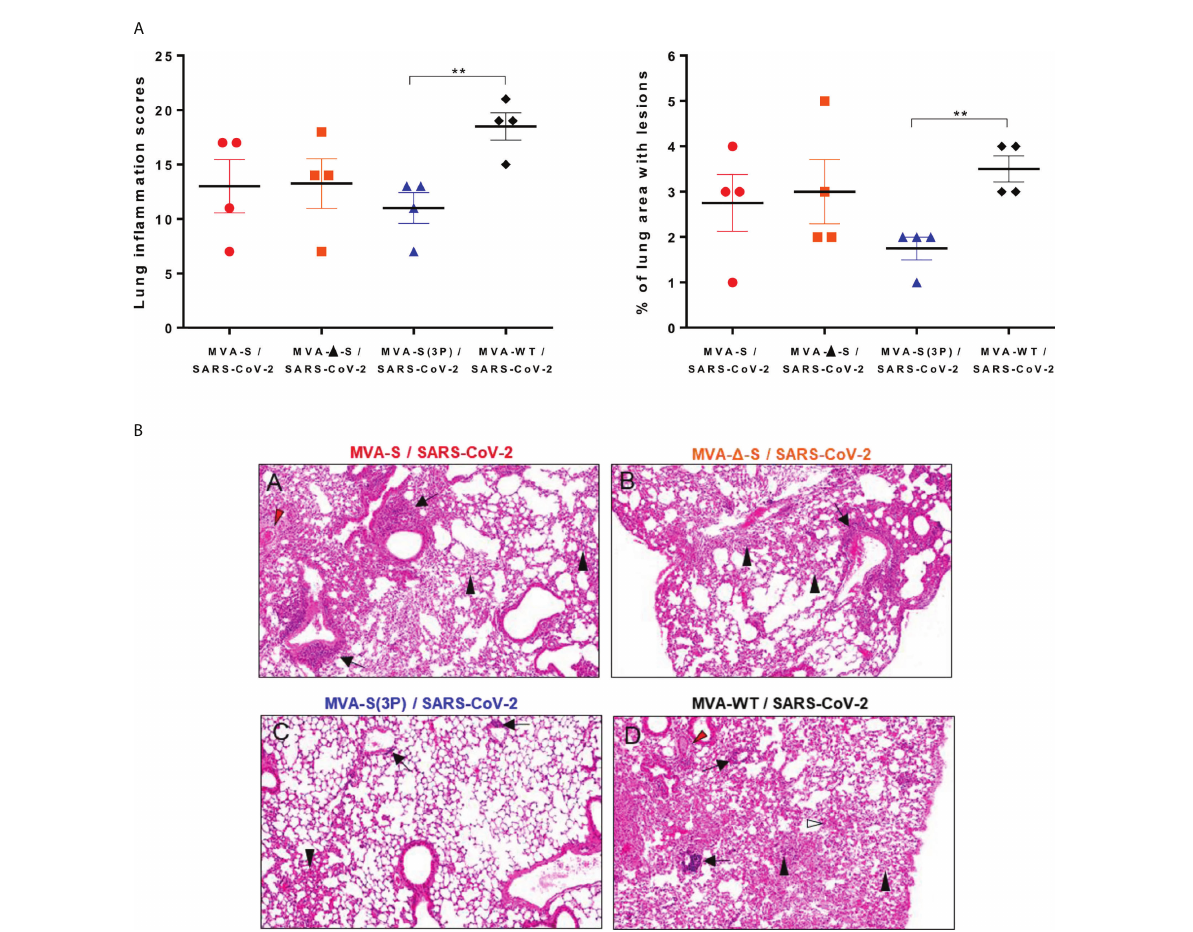
Figure 3A, and euthanized at 5 days postchallenge. Mean and SEM of cumulative histopathological lesion scores (left) and percentage of lung area affected by in fl ammatory lesions (right). Unpaired t -test: ** p < 0.01. (B) Representative lung histopathological sections (H&E staining) from K18-hACE2 mice euthanized at day 5 postchallenge (magni fi cation: 10×). Mice immunized with one dose of MVA-S (A) and MVA- D -S (B) displayed moderate in fl ammatory lung lesions that were, in general, more severe and extensive in mice immunized with MVA-WT (control infected group; d). These lesions highlighted the presence of diffuse thickening of the alveolar septae, perivascular edema (red arrowheads), mononuclear cell in fi ltrates within alveolar spaces (black arrowheads), large multifocal perivascular and peribronchiolar mononuclear in fi ltrates (black arrows), and occasional hemorrhages (white arrowheads). However, mice immunized with MVA-S(3P) (C) only displayed small lung areas with mild in fl ammatory lesions such as focal thickening of alveolar septae, occasional presence of mononuclear cell in fi ltrates within alveolar spaces (black arrowheads), and mild perivascular or peribronchiolar mononuclear in fi ltrates (black